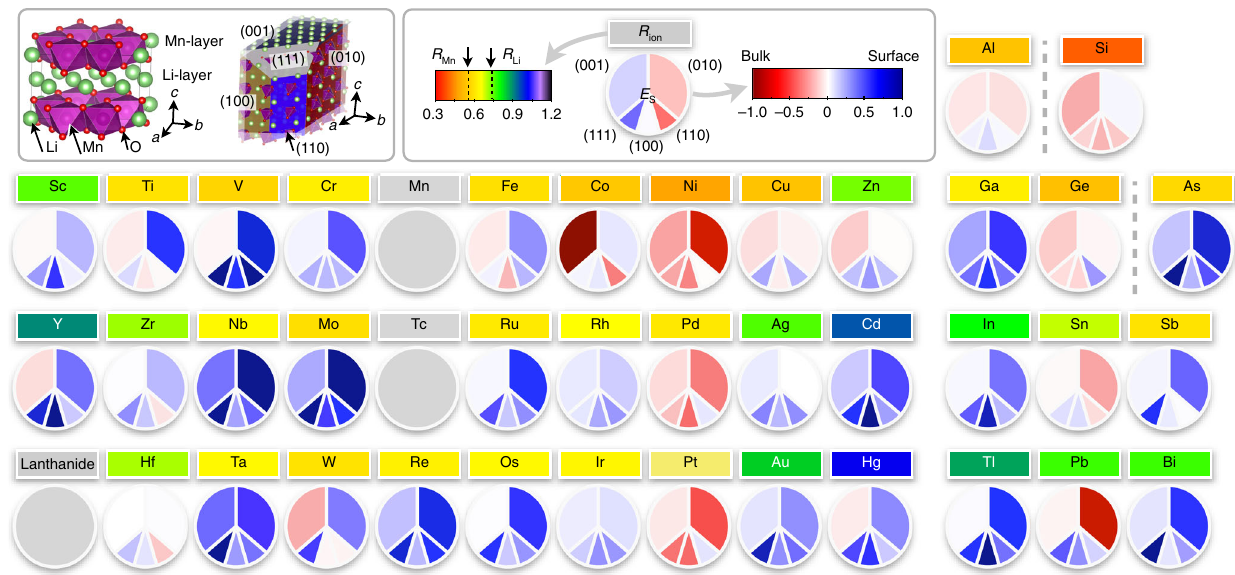
Fig. 1 The dopant segregation energy as a function of dopant element for the 5 most stable low index surface facet in Li 2 MnO 3 . The circular charts are designed to give a visual overview of the surface segregation driving force by indicating red for bulk and blue for surface preference, respectively. The rainbow color scheme forming the background of the element label indicates the ionic radius of the dopant as analyzed using the result of the oxidation state of the dopant and tabulated Shannon radii. Additionally, the radii of the host cations R Mn (0.53 Å) and R Li (0.76 Å) are marked by dashed lines in the legend. A comprehensive list of dopant oxidation state and their ionic radius are presented in the supporting information (Supplementary Table